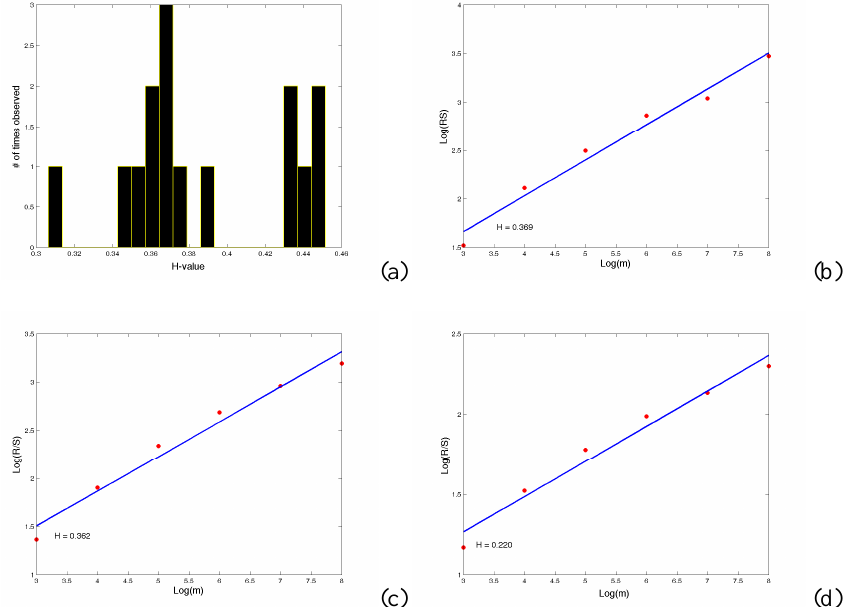
Fig. 4. (a) Histogram of the Hurst exponents resulting for the 15 relaxation parts of the “p023” ECG time series. (b) Sample application of the R (cid:14) S method to an indicative relaxation interval of the pathological heart taken from the ECG time series of the subject “p023”. (c) R (cid:14) S analysis of the total length of the noncritical MHz EM emission excerpt of Fig. 2e associated with the Kozani–Grevena EQ. (d) R (cid:14) S analysis of the total length of the noncritical MHz EM emission excerpt of Fig. 3e associated with the L’Aquila EQ.